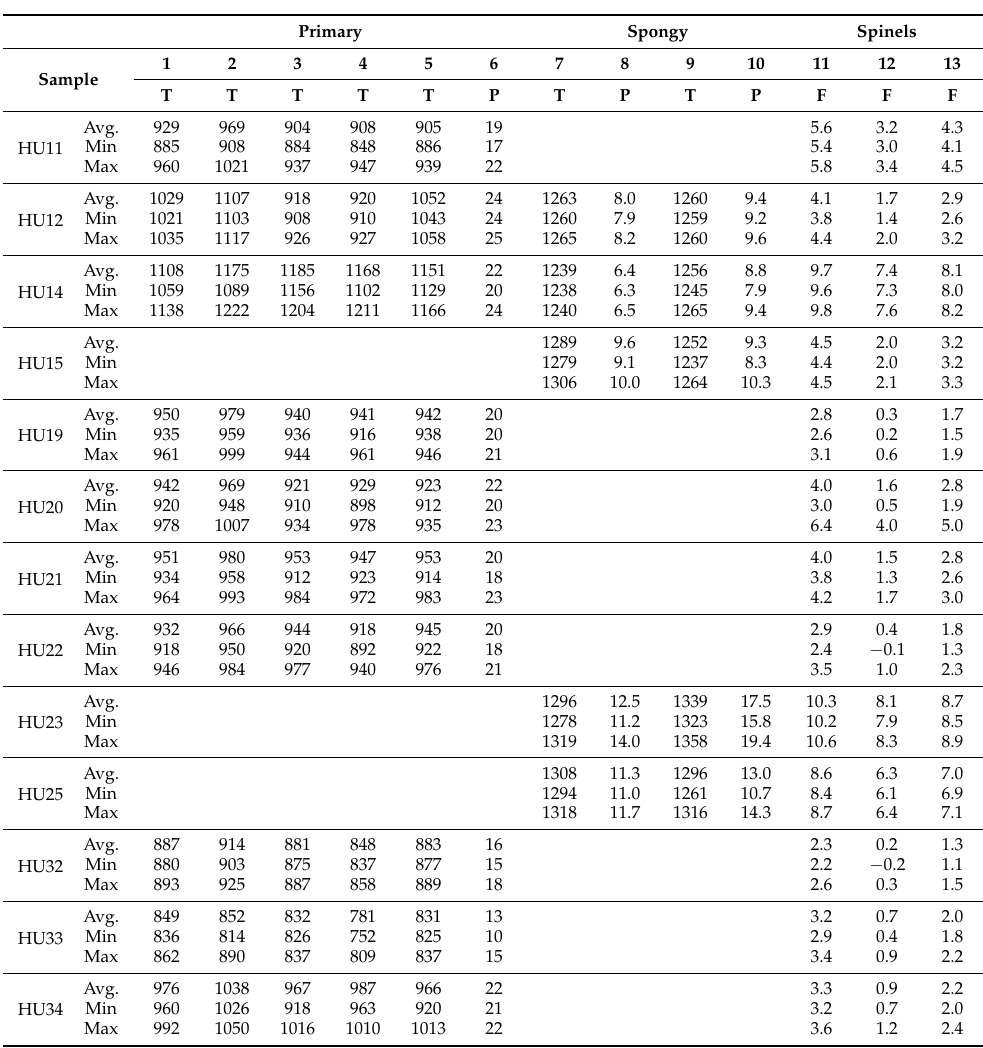
Table 3. Calculated T ( ◦ C), P (kbar) and F (%) of Huanul xenoliths. Geothermometers: (1) Wells [52]; (2) two-pyroxene, Brey and Kohler [54]; (3) Ca in Opx, Brey and Kohler [54]; (4) Taylor [55]; (5) Nimis and Grutter [56]; (7) Equation 2 from Wang et al. [58]; (9) Equation 32d from Putirka [59]. Geobarometer: (6) Mercier [53]; (8) Equation 1 from Wang et al. [58]; (10) Equation 32a from Putirka [59]. Degree of melting (F): (11) Batanova et al. [61]; (12) Hellebrand et al. [62]; (13) Warren